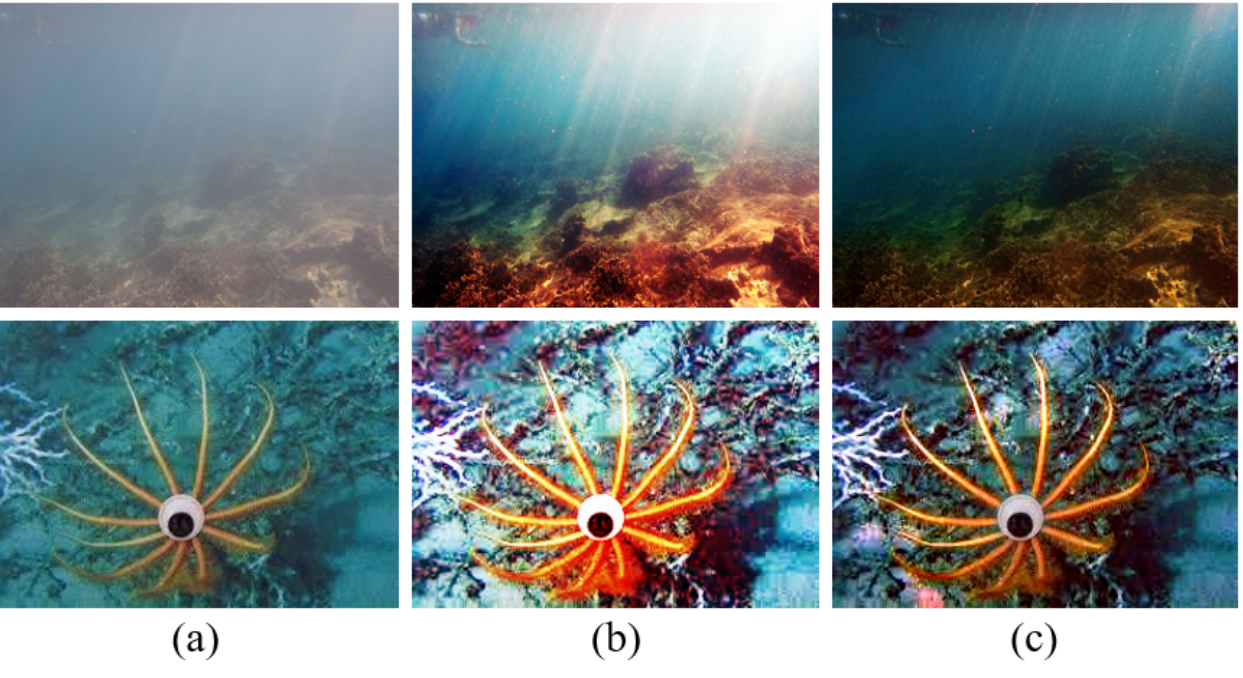
Figure 1. A comparison of underwater image enhanced results. ( a ) Underwater images. The enhanced images obtained using ( b ) the HE[4], and ( c ) ref. [9] for the underwater